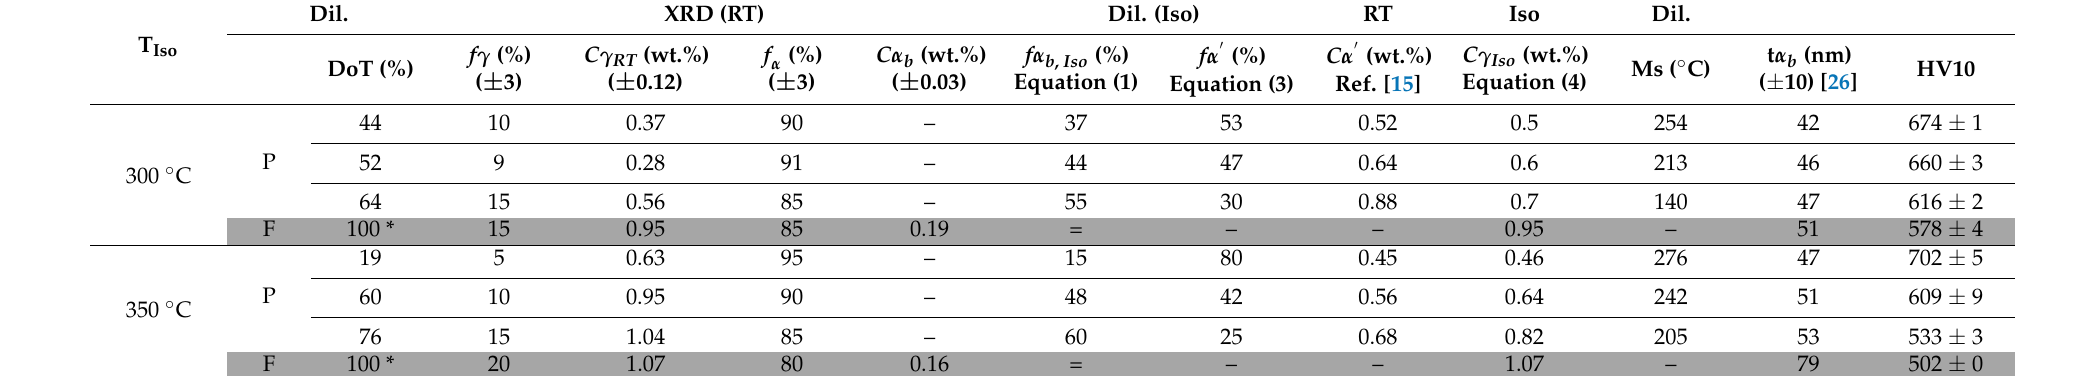
Table 3. Volume fraction ( fi ) and carbon content ( Ci ) of identified phase in the microstructures of 04C3Si at room temperature; α b is bainite, α (cid:48) is martensite, γ is austenite and α = α b + α (cid:48) . P and F stand for partial and full transformation, while RT refers to room temperature and Iso refers to isothermal temperature. The martensitic transformation start temperature Ms, plate thickness ( t α b ) and hardness HV10 are also included. An asterisk (*) indicates that no martensite was detected on cooling to room T. Dil. stands for dilatometry and DoT stands for degree of